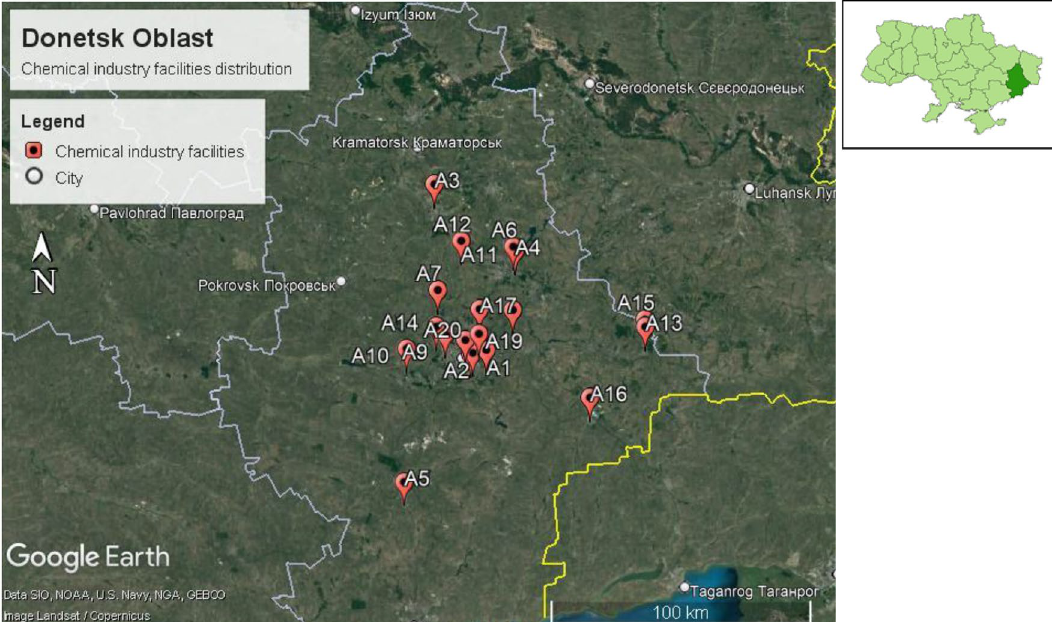
Figure 6. Chemical plant distribution in Donetsk Oblast in Ukraine.